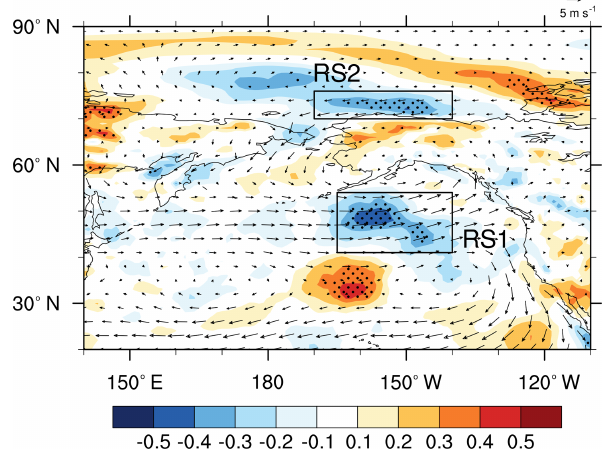
Figure 7. The distribution of the climate mean surface wind (ar- row) in November and the CC between the BSISO and surface wind speed in November from 1979 to 2015, after detrending. The black dots indicate CCs exceeding the 95% confidence level ( t test). The black boxes (RS1 and RS2) are the significantly correlated areas, which were used to calculate the WSPD RS1 and WSPD RS2 index.